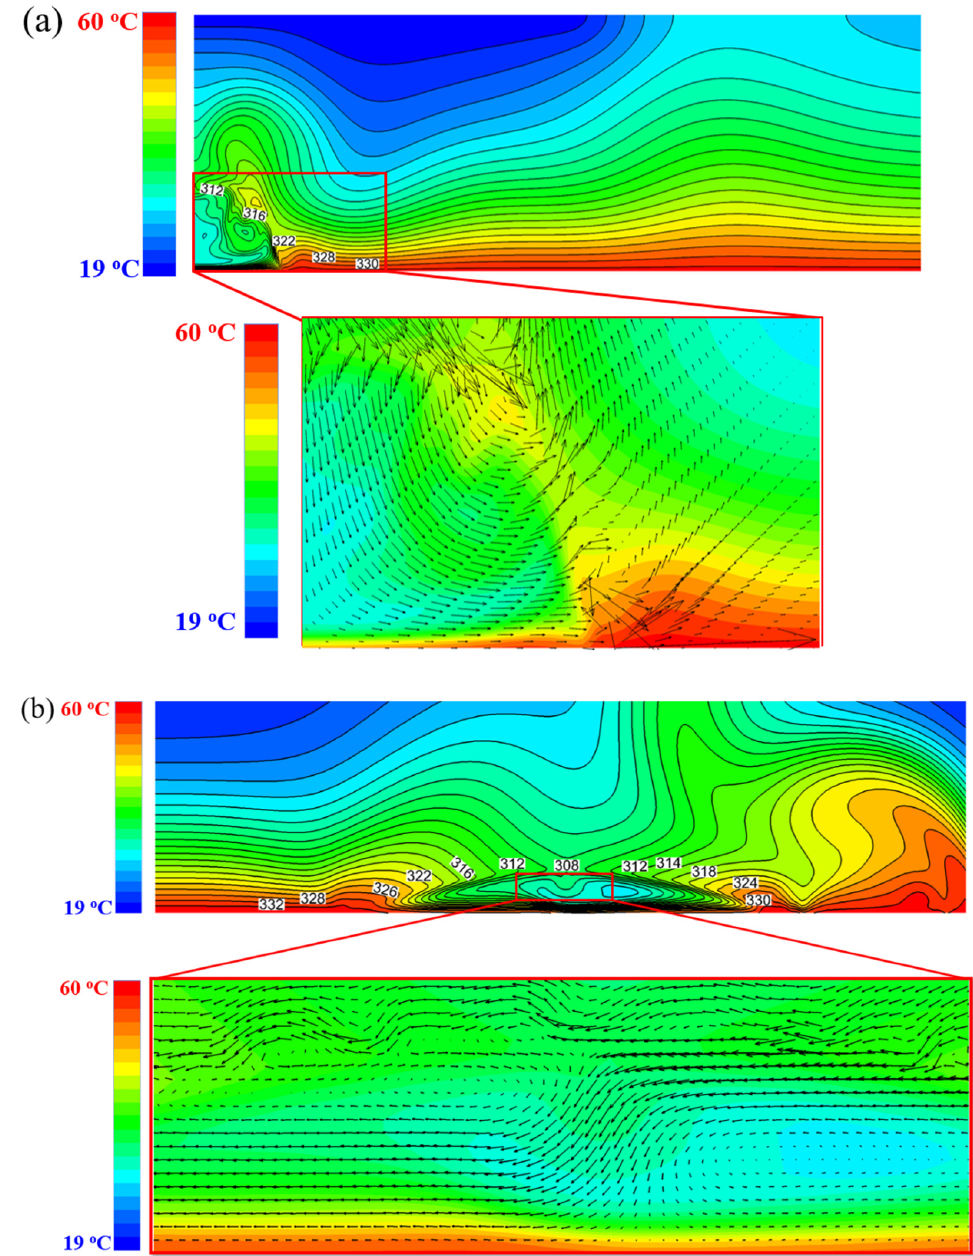
Figure 13. Isothermal curve and velocity vector distribution of the liquid film on ( a ) hydrophilic surface and ( b ) superhydrophilic surface at t = 17.75 ms for W e = 16, T w = 60 °C.